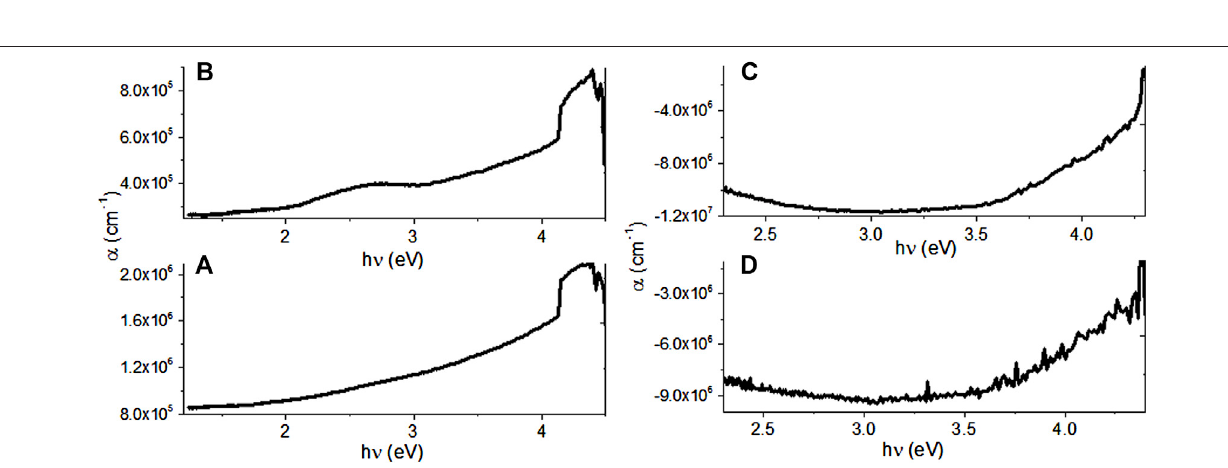
Frontiers in Materials |